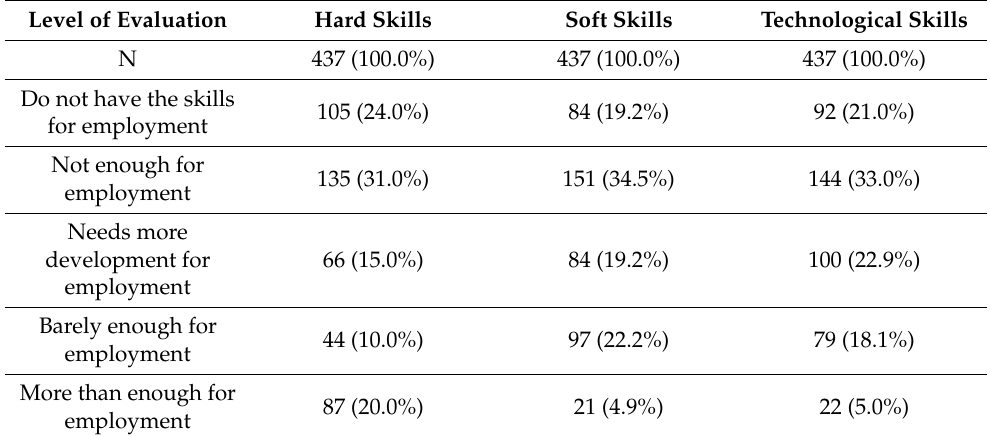
Table 5. Frequency of evaluation of current skills set for future employability.